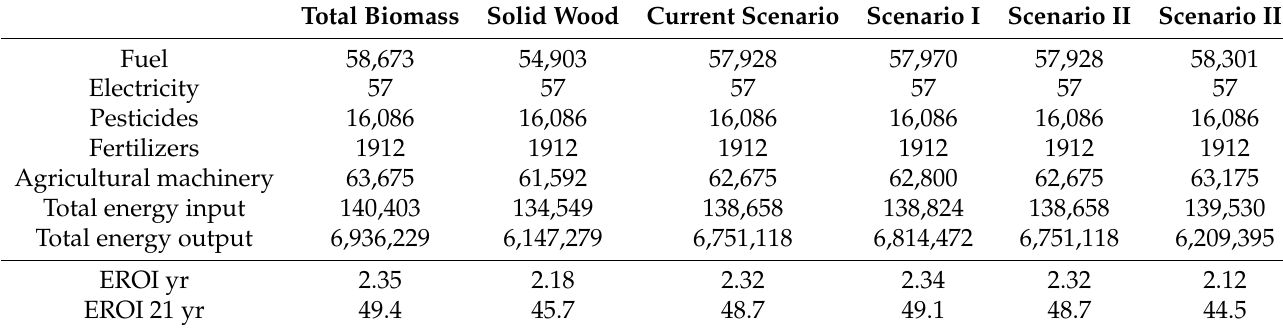
Table 9. Energy inputs and energy output of agroindustrial forestry chain. All values are expressed in MJ ha − 1